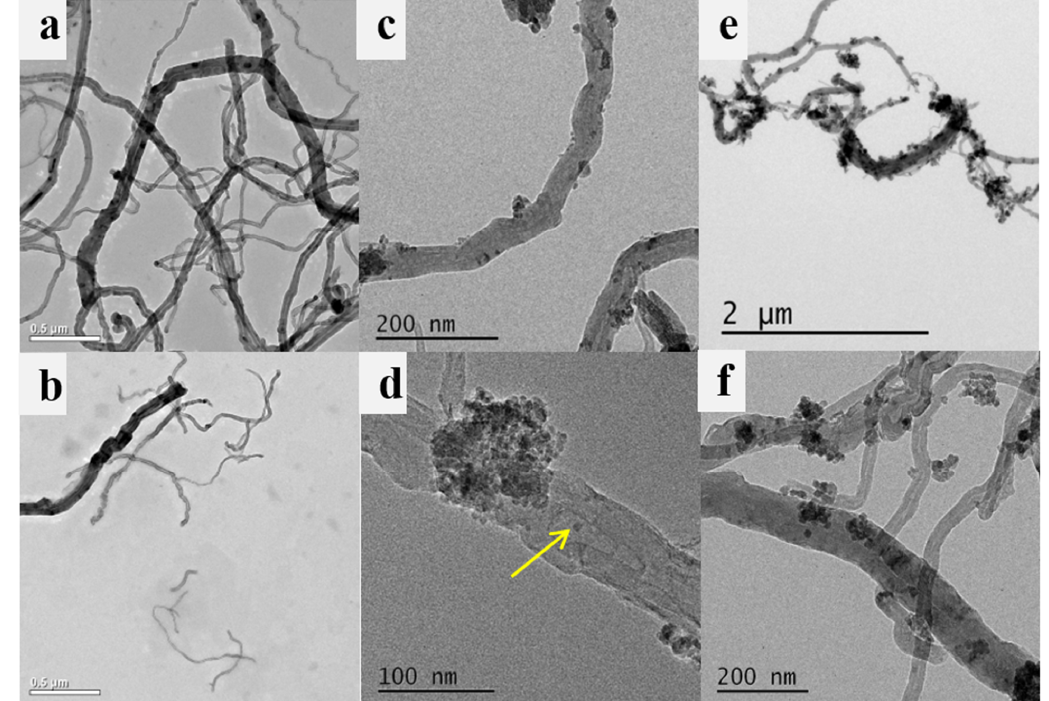
Figure 2. TEM images of ( a ) crude MWCNTs; ( b ) oxidized MWCNTs; ( c ) magnetic MWCNTs; ( d ) magnified image of mMWCNTs with iron oxide nanoparticles in its internal cavity; ( e , f ) mMWCNTs modified with 4-arm-PEG-NH 2 polymer.